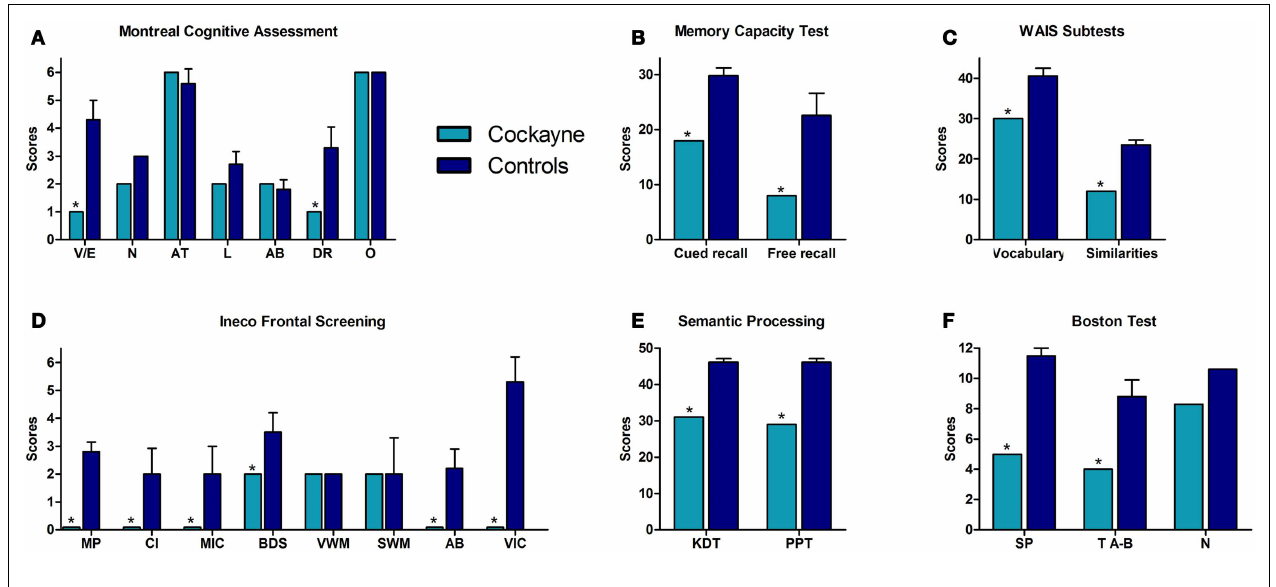
FIGURE 1 | Performance of the CS patient and controls in neuropsychological tests . (A) Montreal Cognitive Assessment (MOCA). V/E, visuo-spatial/executive skills; N, naming; AT, attention; L, language; AB, abstraction; DR, delayed recall; O, orientation. (B) Memory capacity test total scores. (C) Vocabulary and similarities raw scores. (D) INECO frontal screening subtests. MP, motor programing; CI,